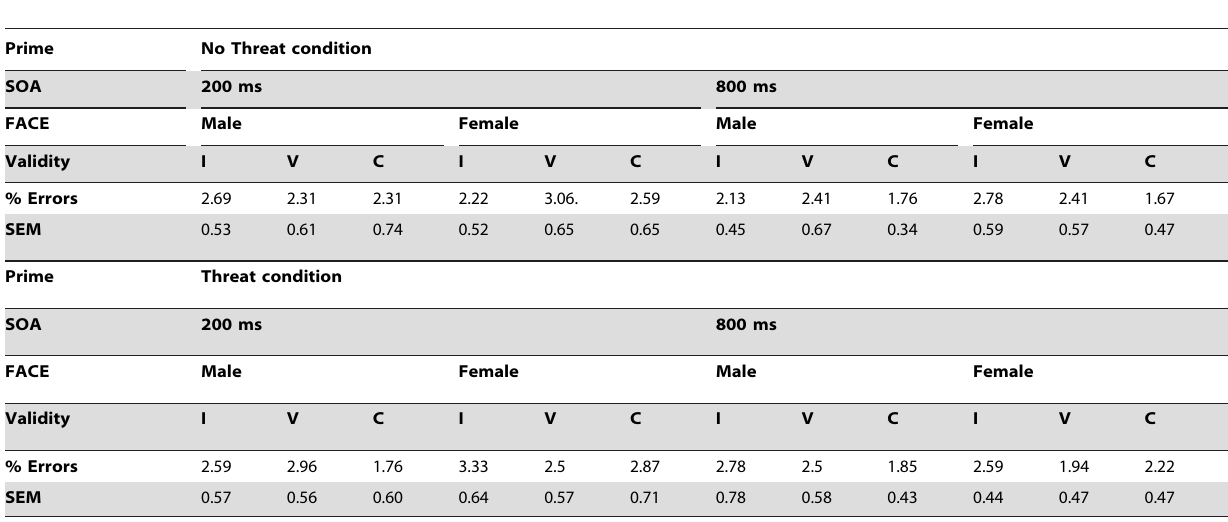
Table 4. Percentage of errors and standard error of the mean in each of the different conditions.